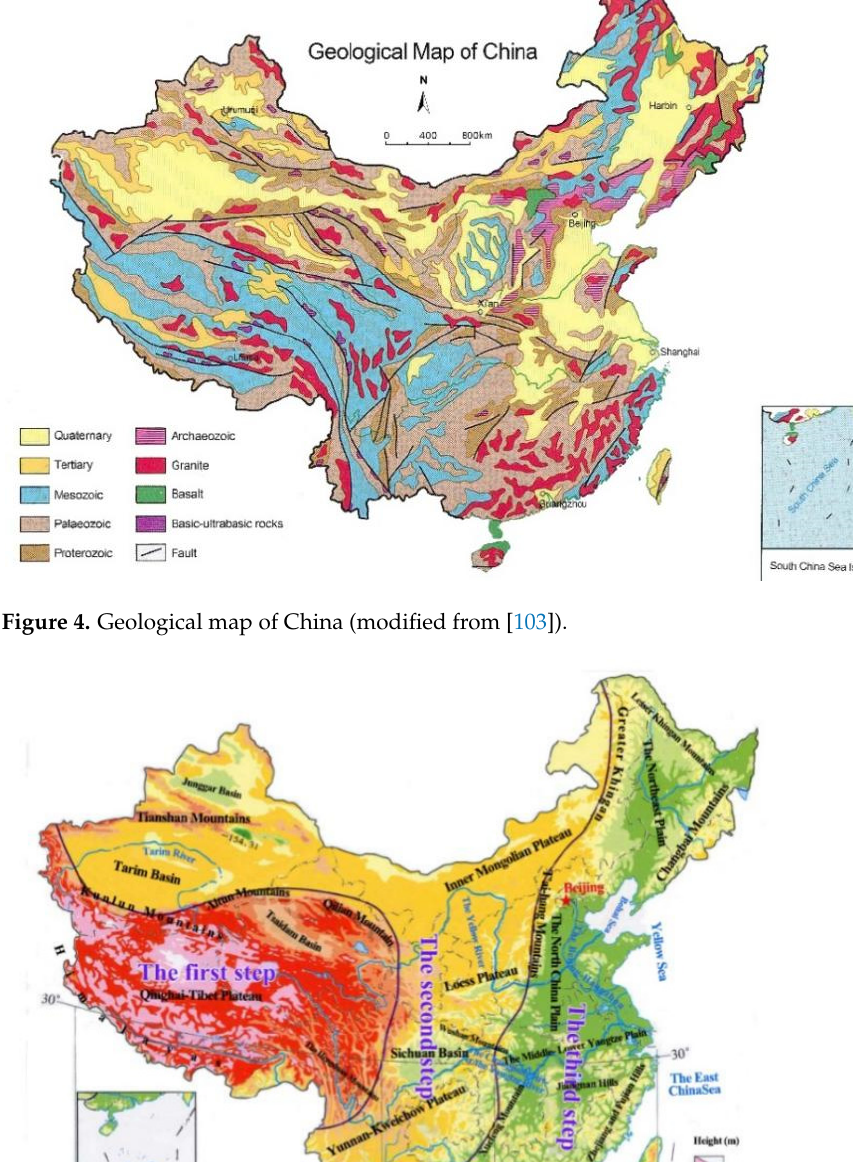
Figure 4. Geological map of China (modified from [103]).